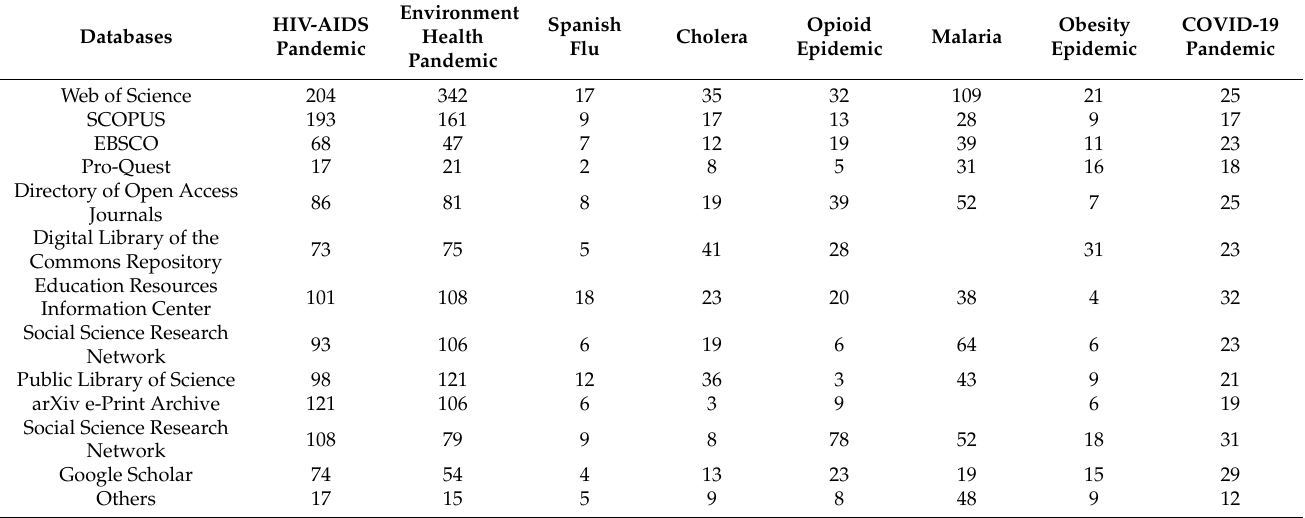
Table 1. Summary of CSR-related global health crisis extracted from databases and other